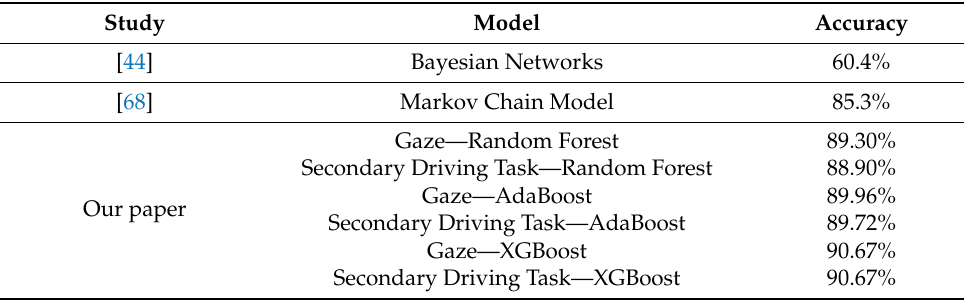
Table 12. Comparison of model algorithms